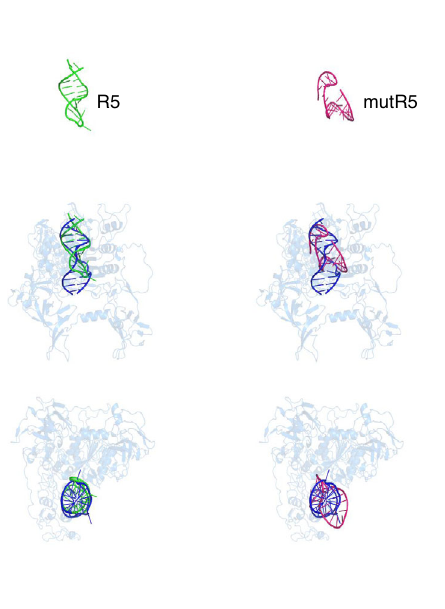
SELEX starting pool are boxed (SL1: red; SL2: light blue; SL3: yellow). d Scheme of theSELEXrounds.Eachroundincludesstepsof:i)incubationofthe RNApoolwith glutathione magnetic beads (counter-selection); ii) recovering of unbound sequences; iii) incubation of the unbound sequences with puri fi ed GST-tagged DNMT1 protein (selection); iv) partitioning of the bound sequences with glu- tathione coupled magnetic beads; v) recovering and ampli fi cation of bound sequences by